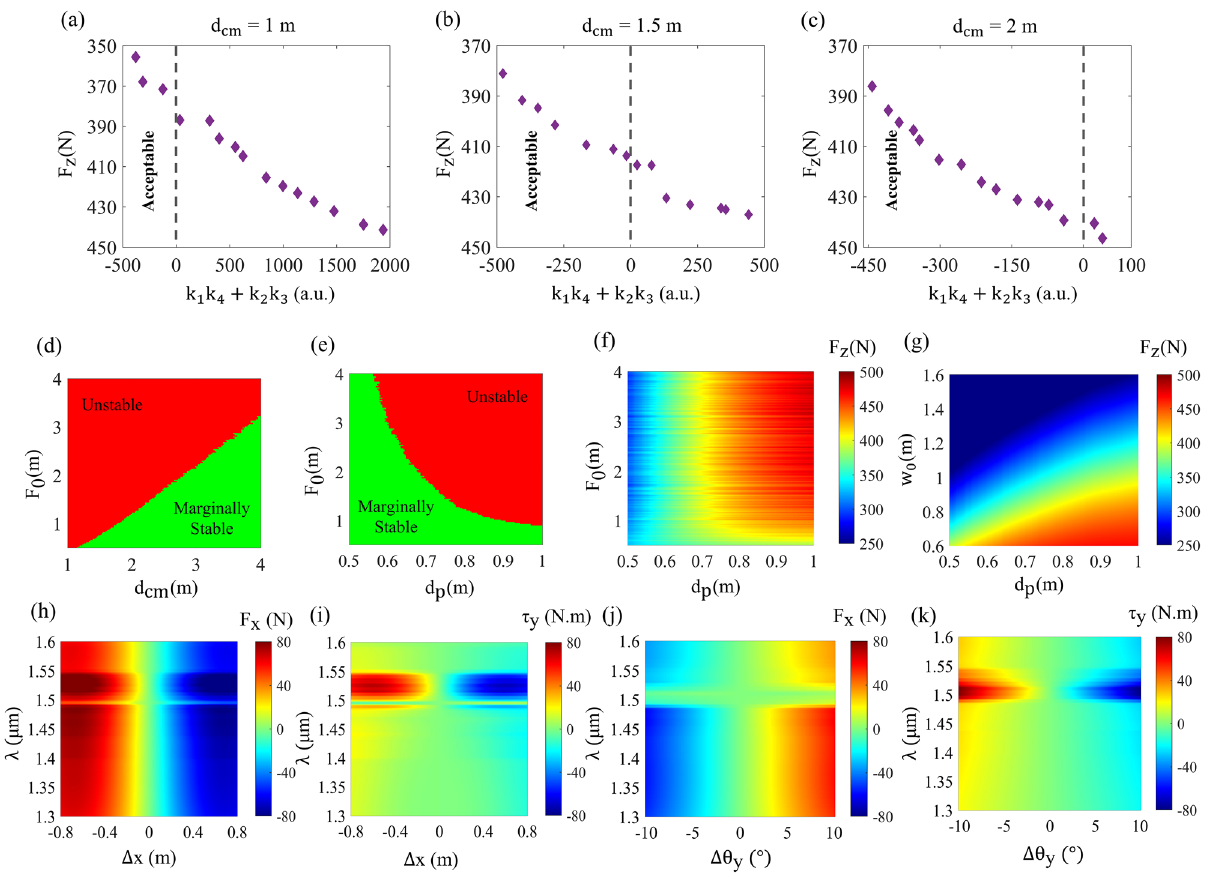
Figure 4. ( a – c ) depicts the obtained Pareto-fronts from the multi-objective optimizations for the center of mass 1 m , d CM 1.5 m and d CM 2 m , respectively. Among the designs in the solution- distances of d CM = = = k 2 k 3 < 0 . space denoted by the Pareto-fronts, the acceptable solutions must satisfy the stability condition k 1 k 4 + ( d ) The marginal stability condition as a function of focal distance of the imprinted phase gradient and the 0.8 m. ( e , f ) The marginal stability condition and imparted center of mass distance of the spacecraft with d p = net thrust as a function of focal distance and radius of central reflective portion of the lightsail for the center 2 m . It should be noted that d of mass located at d CM p is the radius of reflective portion. ( g ) The imparted = net thrust as a function of beam spot size and radius of central reflective portion. ( h , i ) The calculated F x and τ y components of the imparted in-plane force and torque as a function of displacement along the x-axis. ( j , k ) The same, as a function of rotational off-set around the y-axis. Generated by